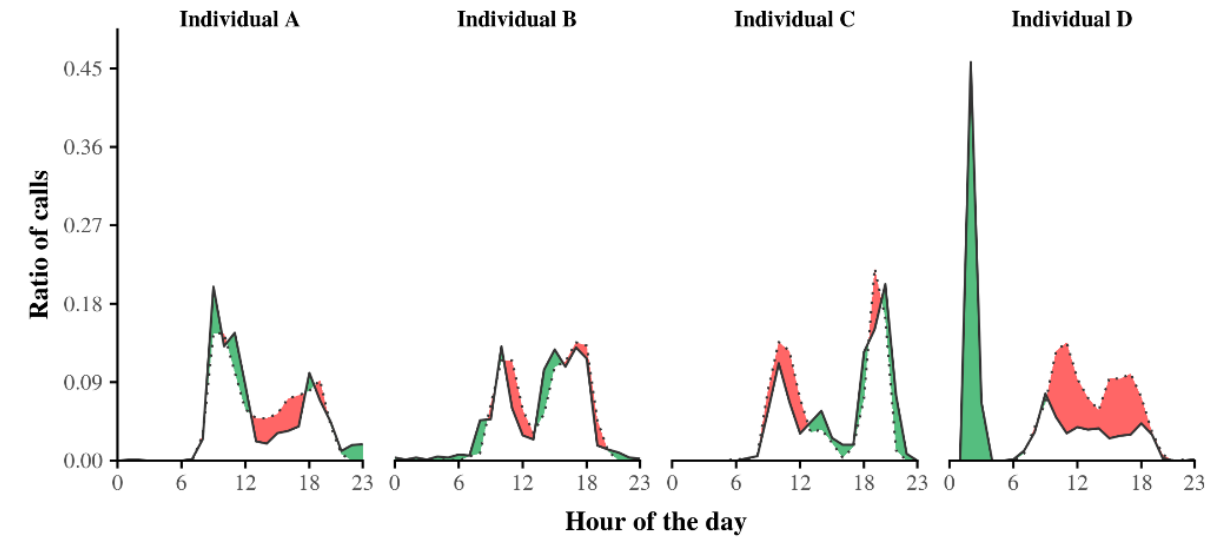
Figure 2. Representative daily rhythms of outgoing and incoming telephone activity for four egos. The solid (dotted) curve shows the outgoing (incoming) call pattern. When the fraction of outgoing telephone calls is greater than the fraction of incoming telephone calls, the difference is shown in green. In the opposite case, the difference is shown in red. The results suggest that both similarities and differences exist in the way the egos place telephone calls and respond to telephone calls during the day. The importance of these observations also appears to vary between egos. In particular, ego D has a prominent nocturnal outgoing telephone call activity that does not appear in the incoming telephone call